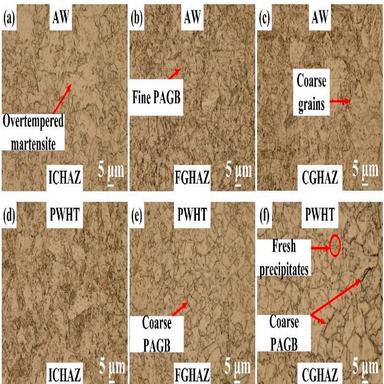
Optical micrographs of P91 HAZ: (a) ICHAZ in AW state; (b) FGHAZ in AW state; (c) CGHAZ in AW state; (d) ICHAZ in PWHT state; (e) FGHAZ in PWHT state; (f) CGHAZ in PWHT state.